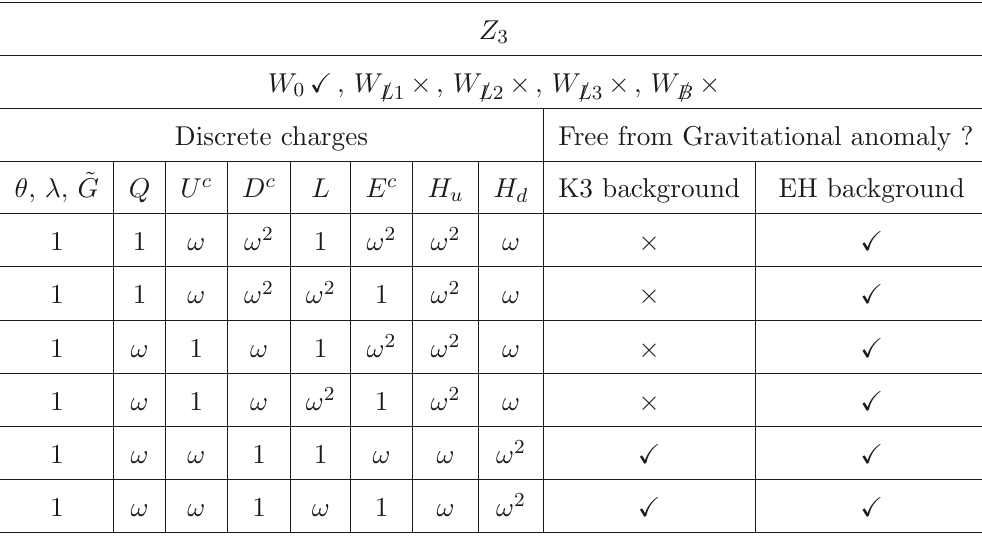
Table 3 . See the caption of table 2 for notations, and refer to the main text for more details. Solu- tions which can be obtained by the replacements ω → ω 2 and ω 2 → ω are removed from the table.